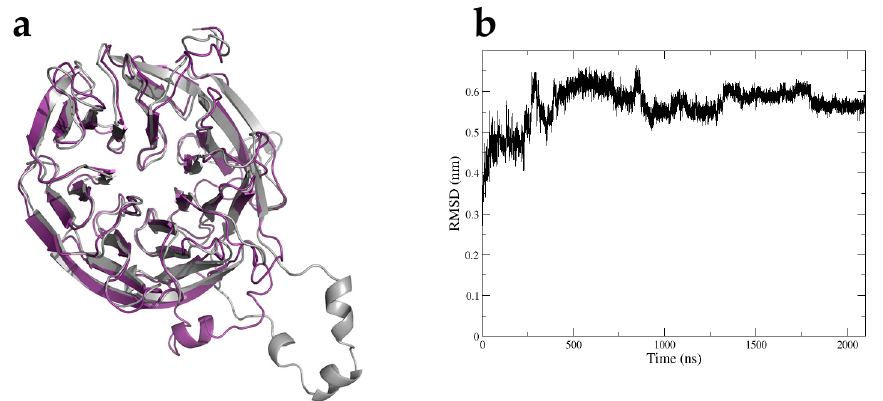
Figure 11. ATG18 structure. ( a ) Three-dimensional structural model of Atg18b before (gray) and after (purple) running the molecular dynamics simulation. ( b ) RMSD of the modeled ATG18b protein over a time period of 2.1 µ